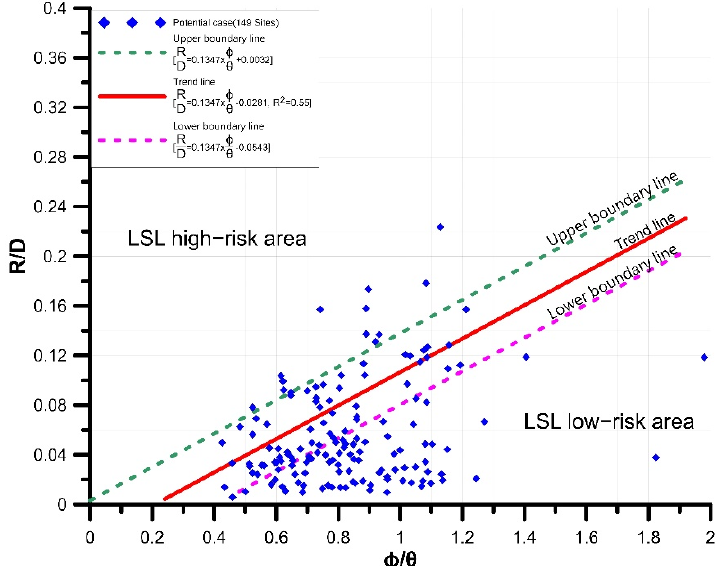
Figure 6. Dimensionless factor relationship of potential LSL area.